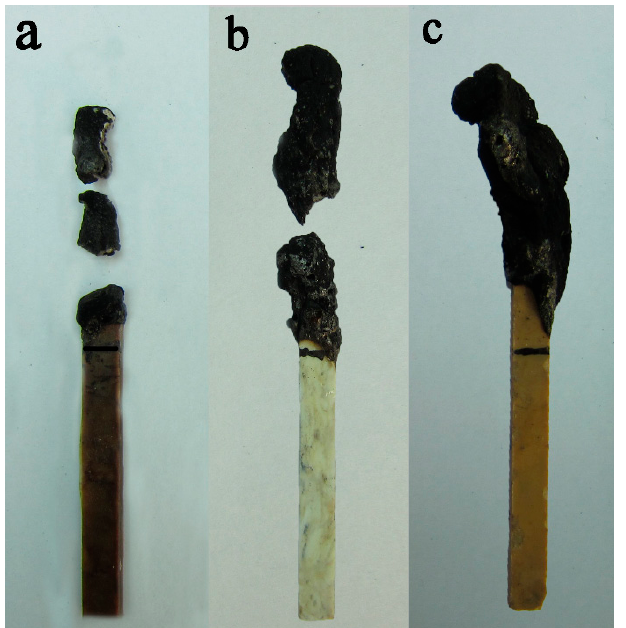
Figure 1. Digital photos of residues from the LOI test: ( a ) 5.1% PI / PA66; ( b ) 17.0%MPP / PA66; ( c ) 11.9%MPP / 5.1%PI / PA66.